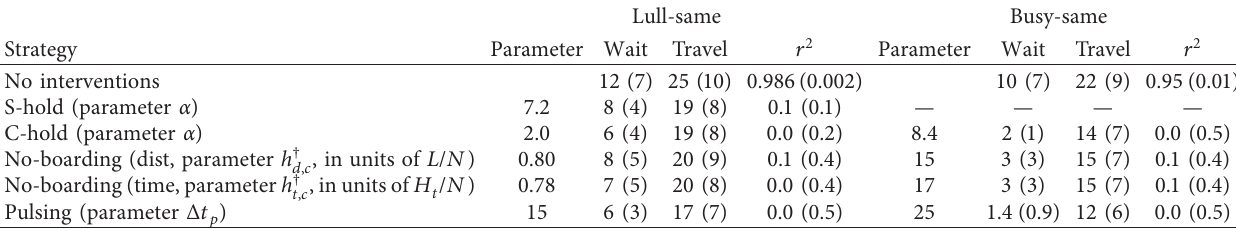
Table 5: Effects of the intervention strategies on the different-velocity scenarios. Each strategy is represented by its best-performing parameter (based on travelling time), with the average waiting time, travelling time (both units of minutes), and degree of complete bunching r 2 presented. The values in parentheses are the standard deviation of each measurement. A null entry represents the control case outperforming the strategy at all parameter values. Lull-different Busy-different Strategy Parameter Wait Travel r 2 Parameter Wait Travel r 2 No interventions S-hold (parameter α ) — — — — — — — — C-hold (parameter α ) 2.8 6 (4) 19 (8) 0.01 (0.01) — — — — , in units of L / N ) — — — — 0.45 3 (3) 15 (7) 0.2 (0.2) No-boarding (dist, parameter h † d,c No-boarding (time, parameter h † t,c , in units of H t / N ) — — — — 0.2 (0.2) Pulsing (parameter Δ t p ) 0.0